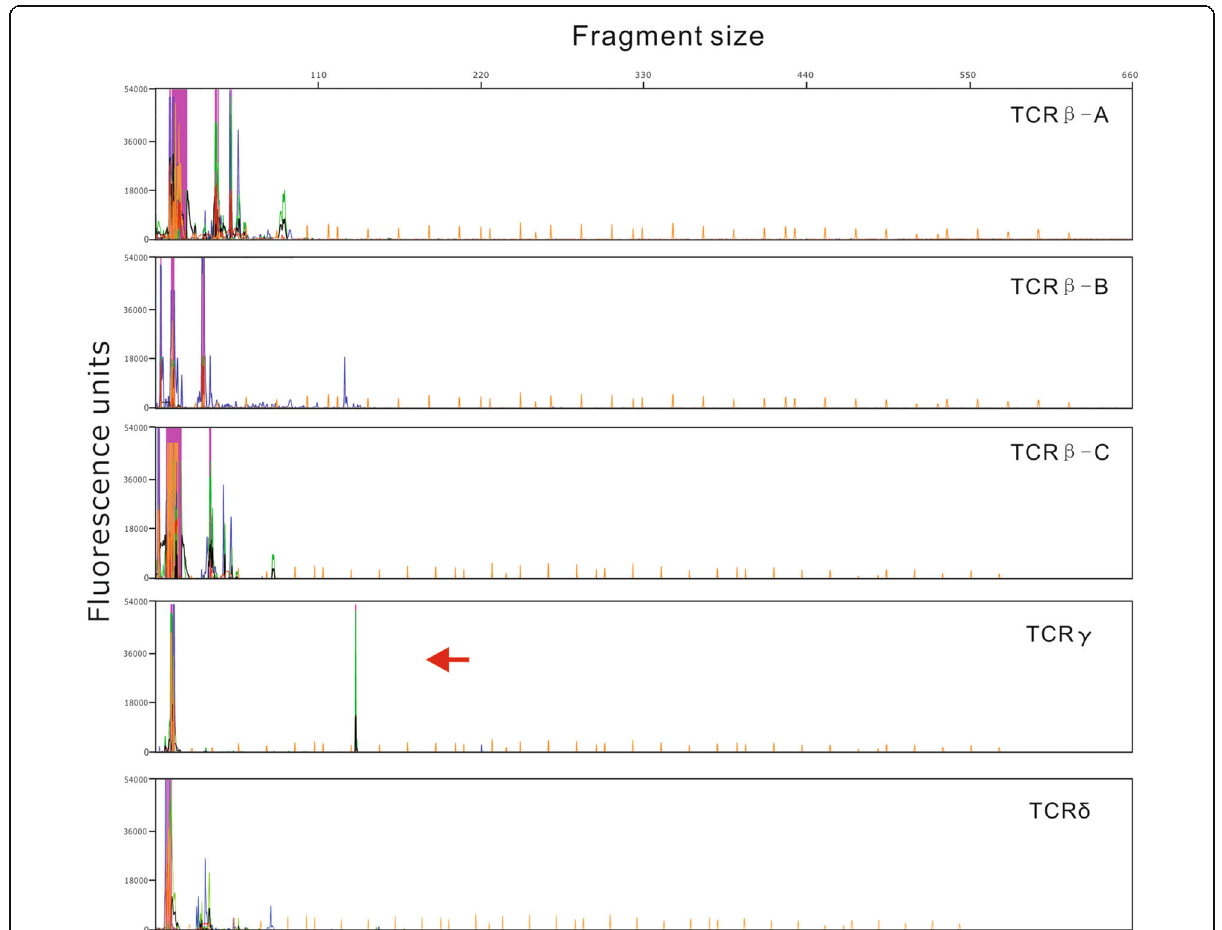
Fig. 4 Molecular testing for gene rearrangement of TCR. The tumor demonstrates a monoclonal peak for TCR-